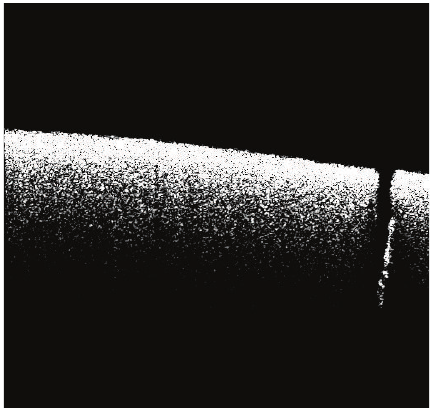
Figure 3: OCT crack measurement. A crack with a 30 𝜇 m width is easily detected on scan. Again the software gives the exact width of the crack. This is typical OCT scan that corresponds to a height of 1.6 mm.